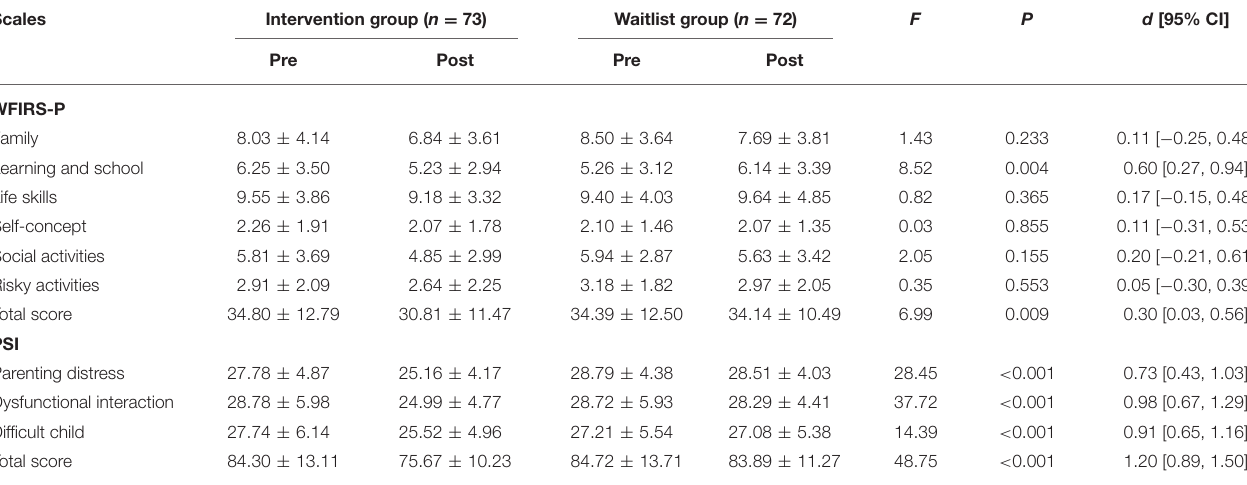
TABLE 5 | Effects of GEF-OPT by WFIRS-P and PSI scores. Scales